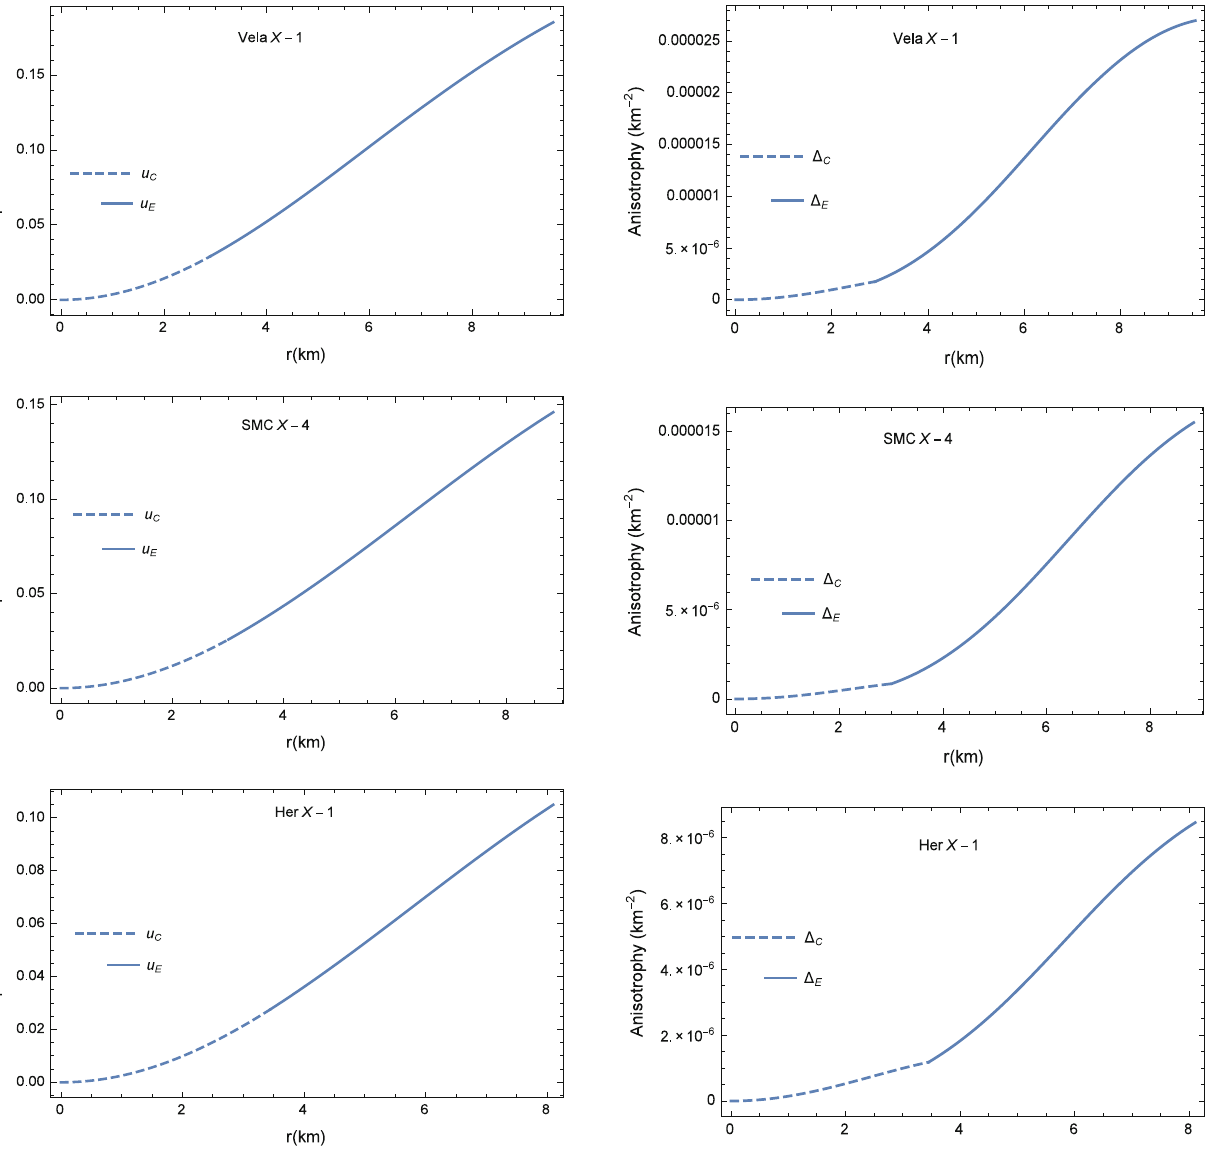
Fig. 7 Variation of compactification factor with radial coordinate r for (i) the neutron star in Vela X-1(upper) (ii) SMC X-4 (middle) (iii) Her X-1 (lower)